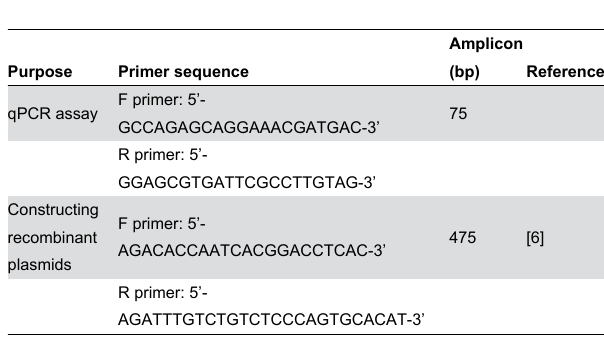
Table 1. Primer sequences used for real-time RT-PCR, constructing and cloning IAPV-recombinant